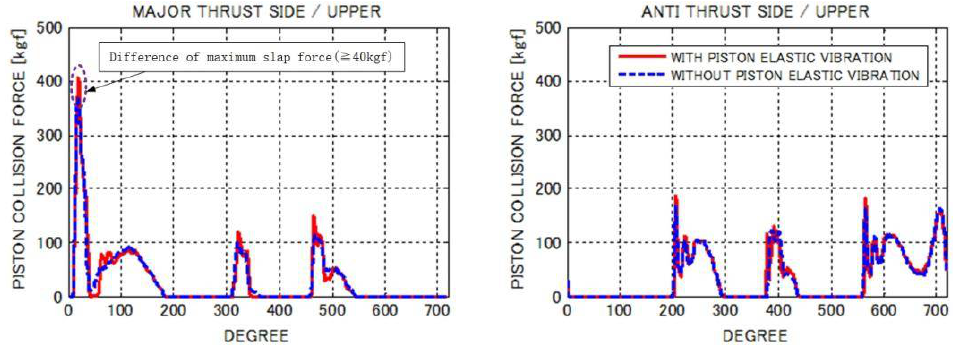
Figure 3. Collision forces of piston with/without dynamic features of the piston .